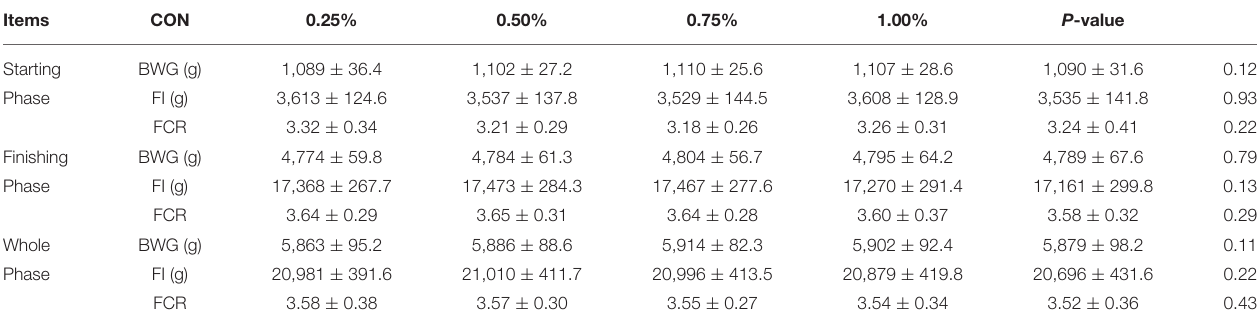
TABLE 2 | Effects of honeycomb flavonoids on growth performances ( n = 4).